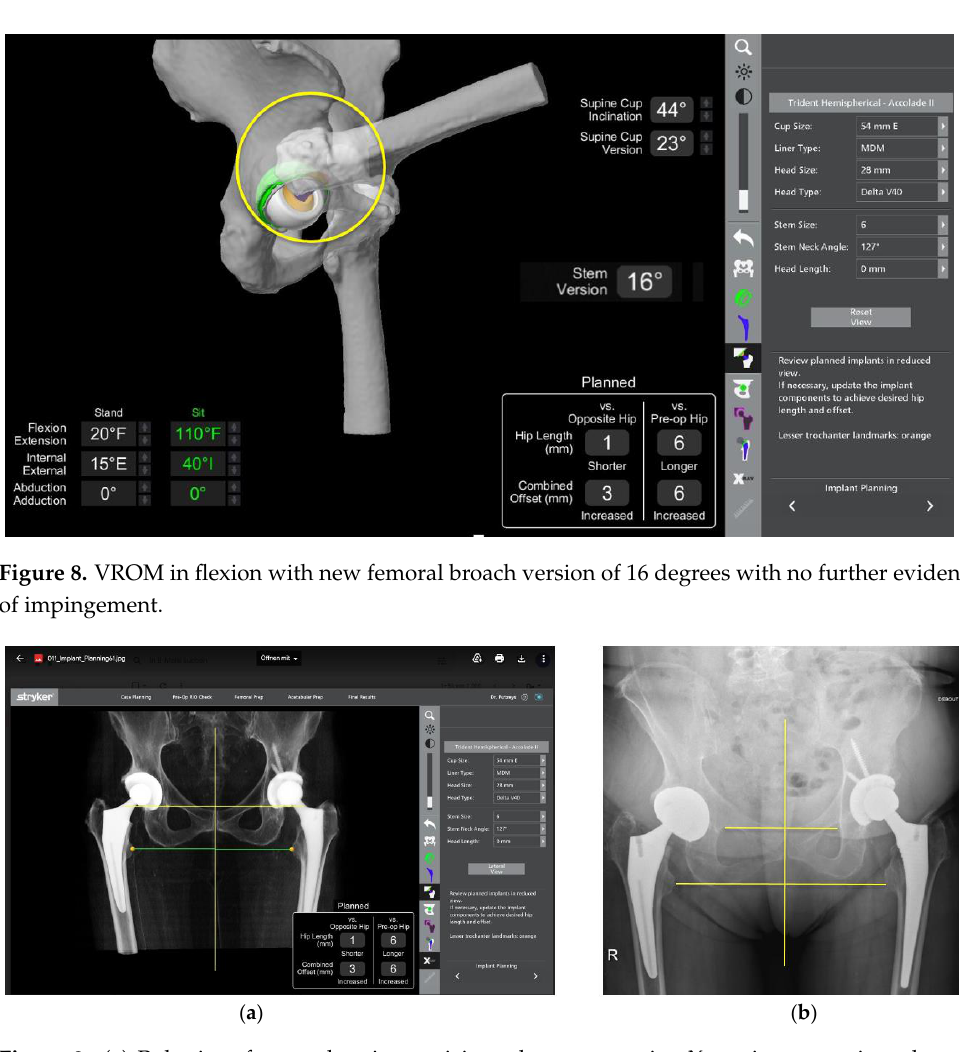
Figure 12. ( a ) Robotic software showing anticipated post-operative X-ray incorporating planned changes in leg length and offset. ( b ) Post-operative X-ray. changes in leg length and offset. ( b ) Post-operative X-ray.